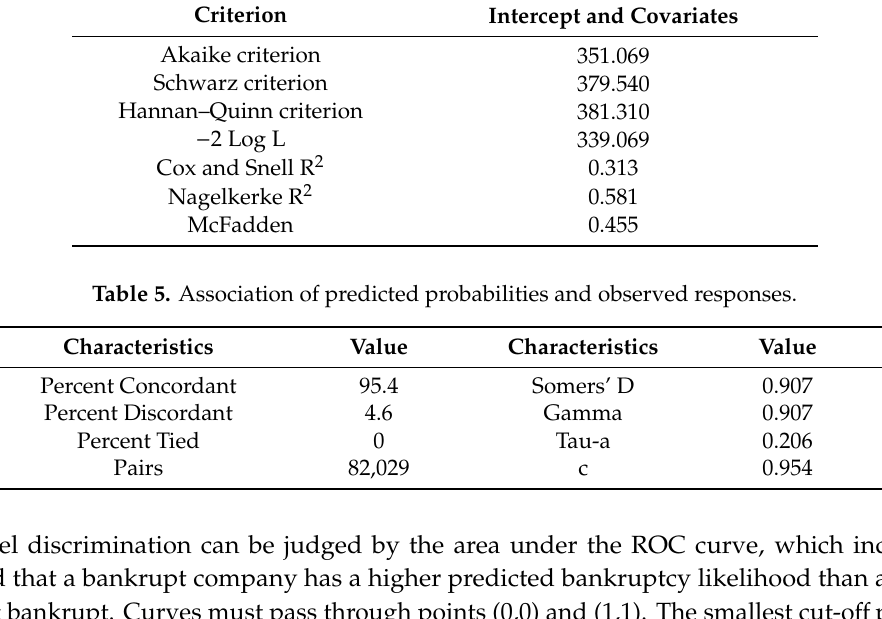
Table 4. Model fit statistics.